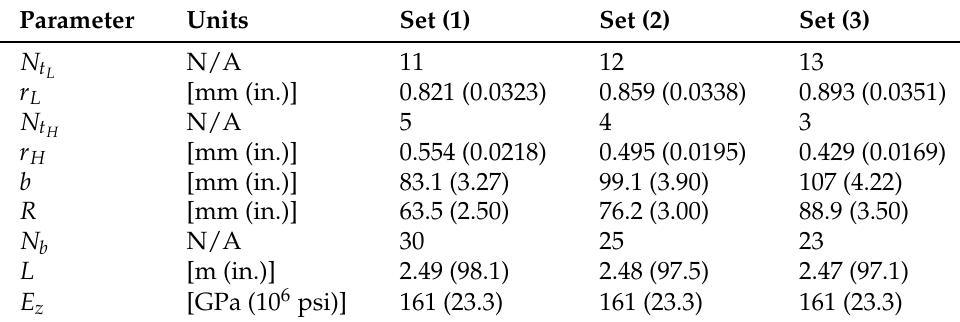
Table 2. Fixed Design Parameters of FE Analyses.